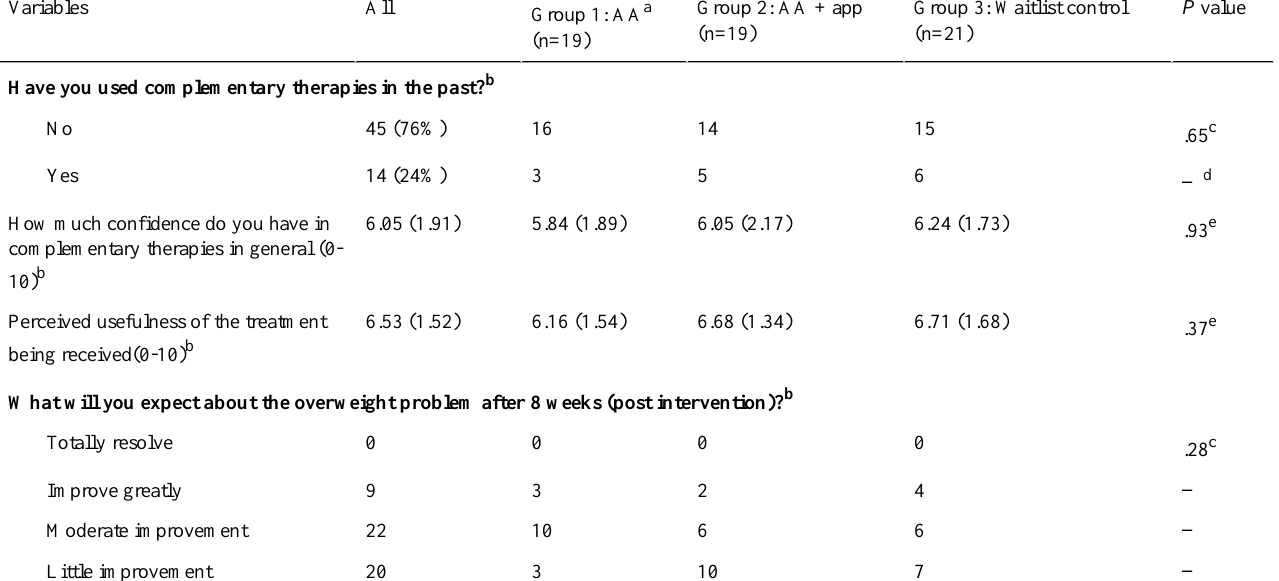
Have you used complementary therapies in the past?